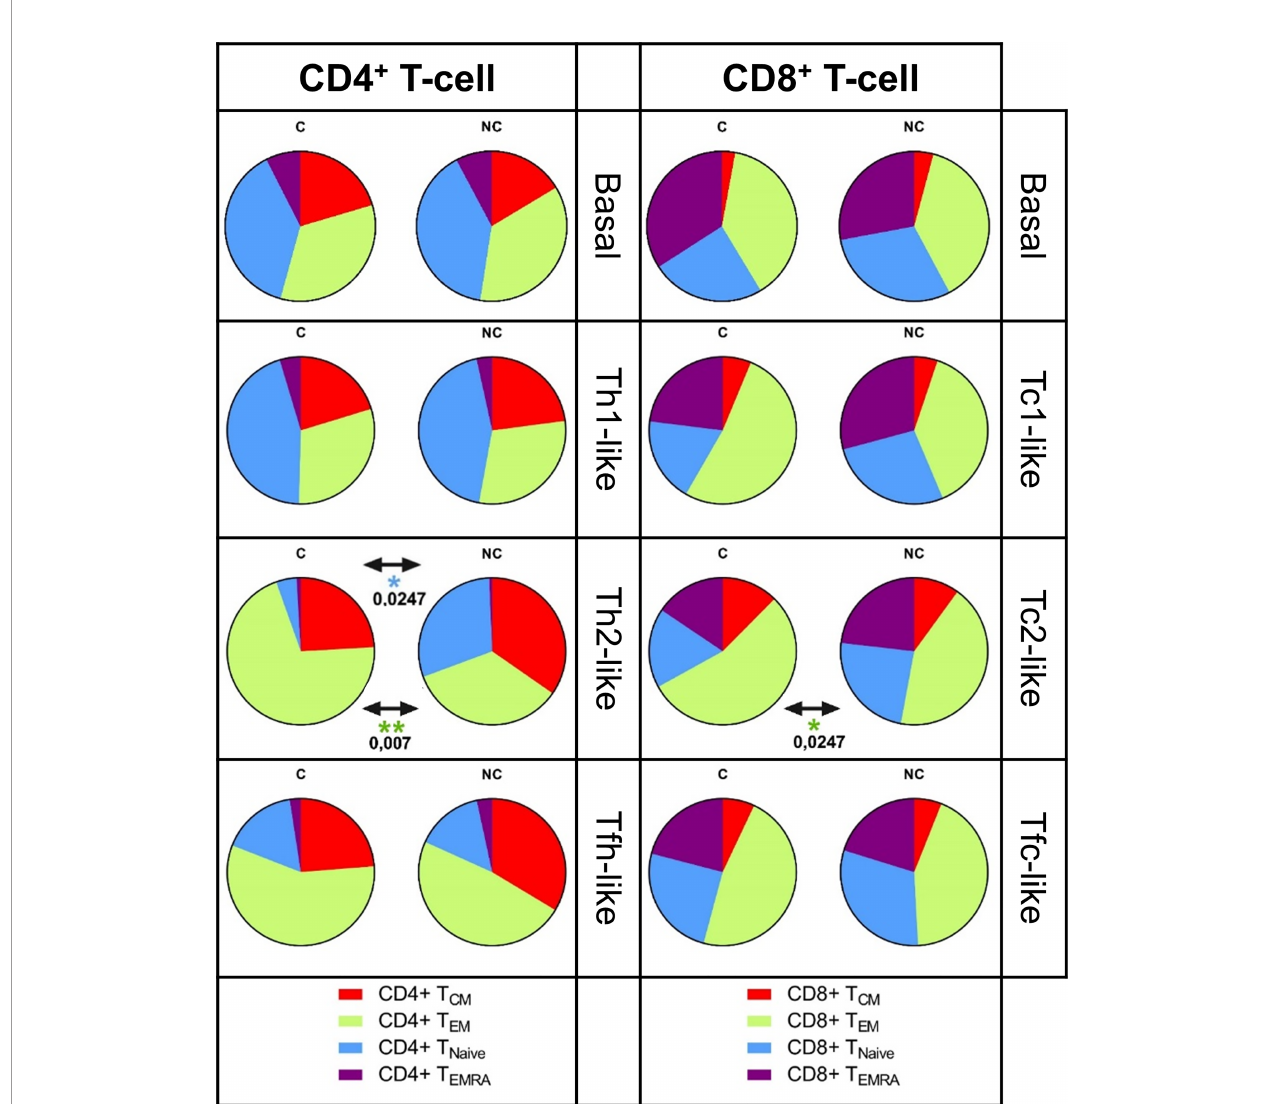
FIGURE 3 | Memory phenotype of the HIV-speci fi c polarized T-cell responses. The frequency of cells expressing memory markers CD45RA and CCR7 was evaluated in both HIV-speci fi c polarized CD4+ and CD8+ T-ce lls. The percentage of basa l, Thl/Tcl, Th2/ Tc2 and Tfh/Tfc-like cells classi fi ed as TcM (CD45RA- CCR7+), TEM (CD45RA- CCR7-), TEMRA (CD45RA+ CCR7-) and TNaive (CD45RA+ CCR7+) are shown in pie charts. Statistical signi fi cance of the differences between HIV-speci fi c memory phenotype in HIV+ controllers (C, left) and HIV+ non-controllers (NC, right) was evaluated by non-parametric Mann-Whitney test, statistical signi fi cance was set at p>O.OS, only signi fi cant results are